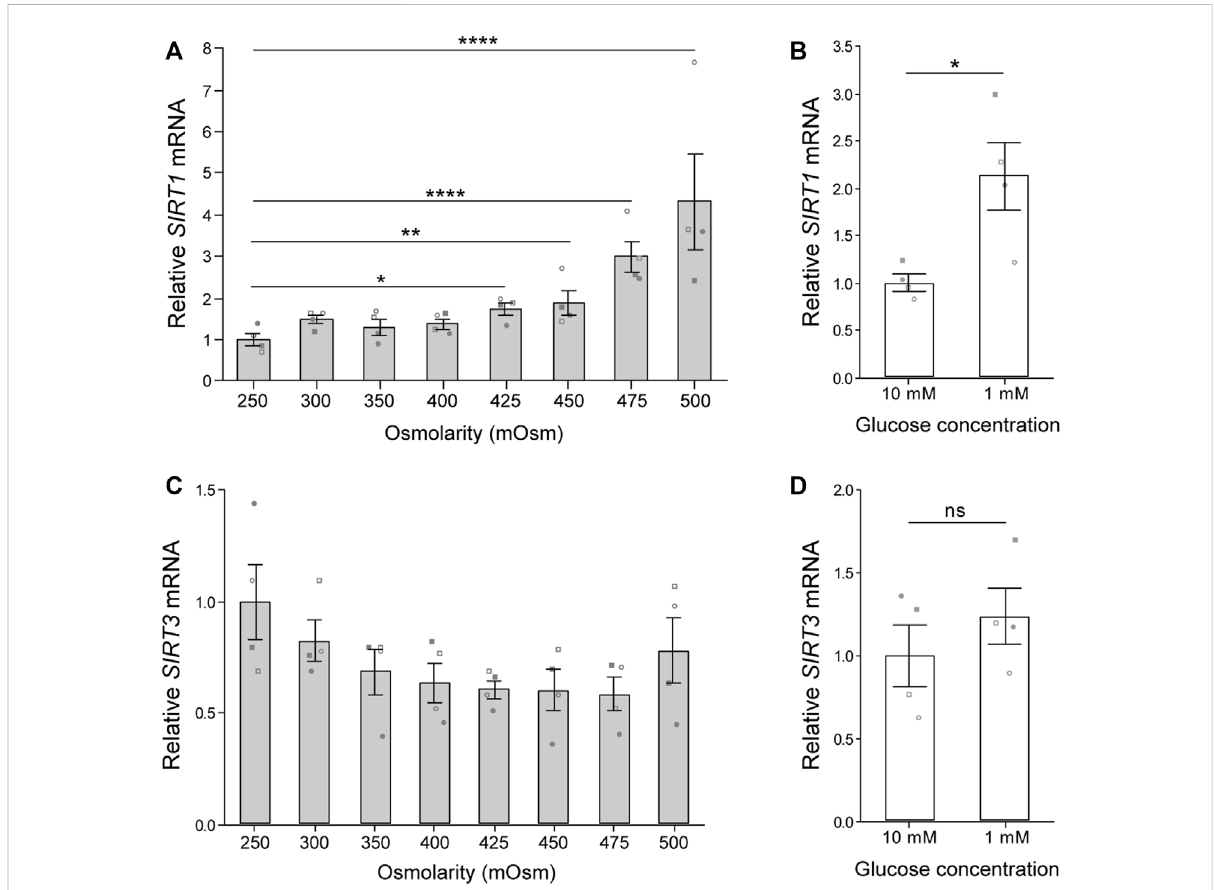
FIGURE 1 Osmolarity and glucose concentration regulate SIRT1 but not SIRT3 gene expression. (A,B) Gene expression of (A) sirtuin-1 ( SIRT1 ) and (B) sirtuin-3 ( SIRT3 ) normalised to β -2-microglobulin ( B2M ) endogenous control and presented relative to 250 mOsm. Mean ± s.e.m., n = 4 donors represented by unique symbols, General linear model with Dunnet multiple comparisons against 250 mOsm: * p = 0.011, ** p = 0.005, **** p < 0.0001. (C,D) Gene expression of (C) SIRT1 and (D) SIRT3 normalised to β -actin (ACTB) endogenous control and presented relative to 10